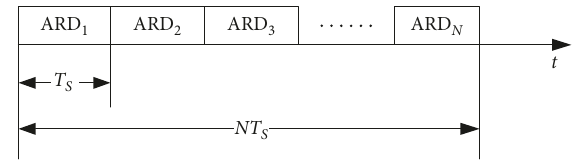
Figure 1: Illustration of ARD spectrum time